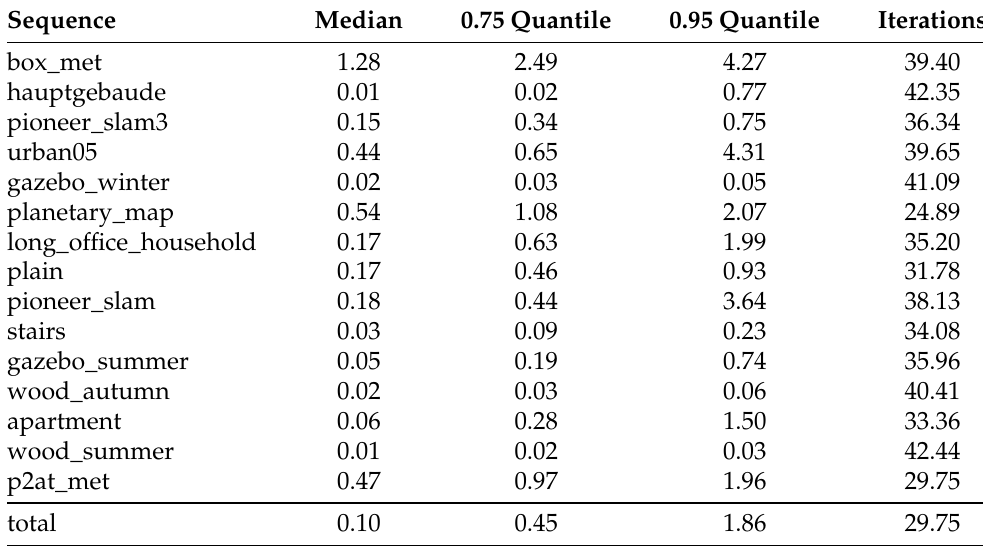
Figure 7. Histograms of the median results of PPCR on a comprehensive benchmark [6] with two different termination criterion (100 iterations and the cost drop). Table 5. Results of PPCR on a comprehensive benchmark [6], using the cost drop with 1% and 20 iterations as